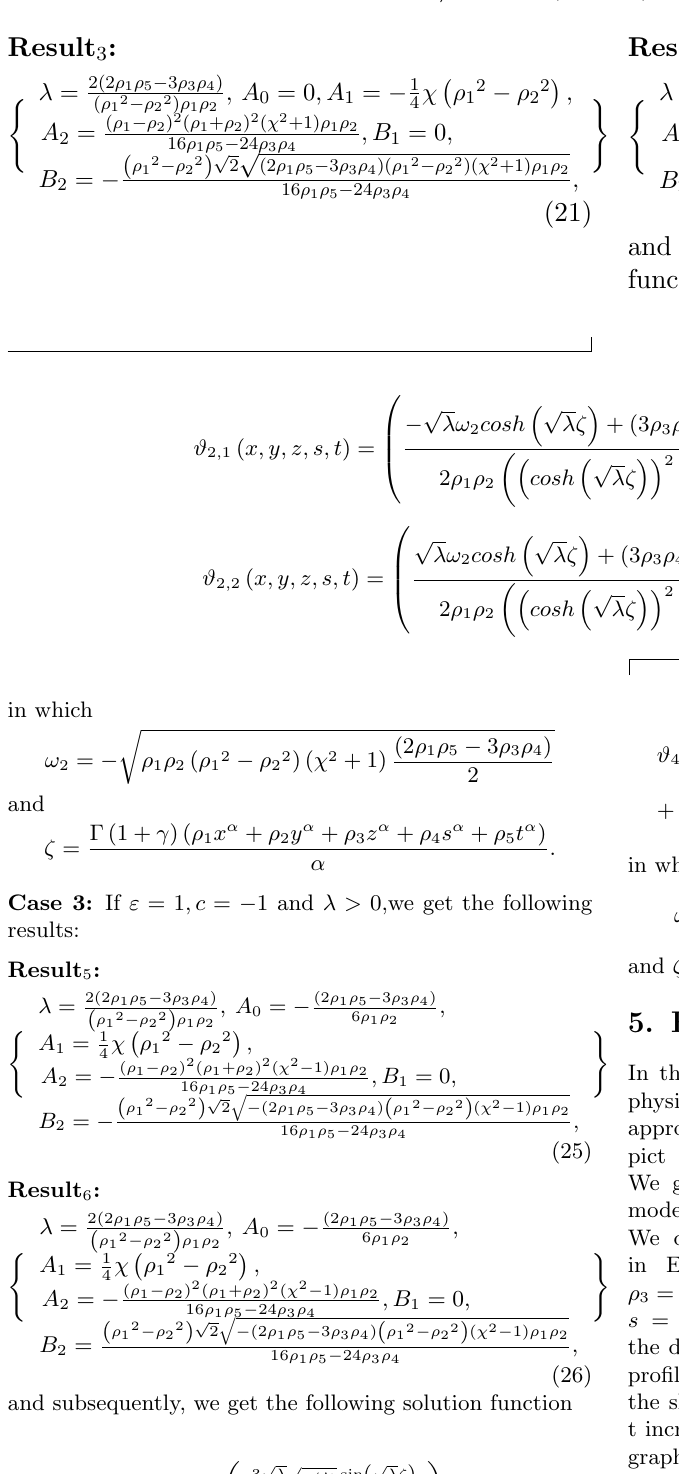
of ϑ 2 , 1 ( x, y, z, s, t ) given in Eq.(23) and these graphs ters ρ 1 = 3 ,ρ 2 = − 1 ,ρ 3 = 3 ,ρ 4 = 1 ,ρ 5 = − 3 ,γ = 0 . 5 , y = 1 , z = 1 , s = 1 , χ = − 5 , and α = 1. Fig. 2-(c) also